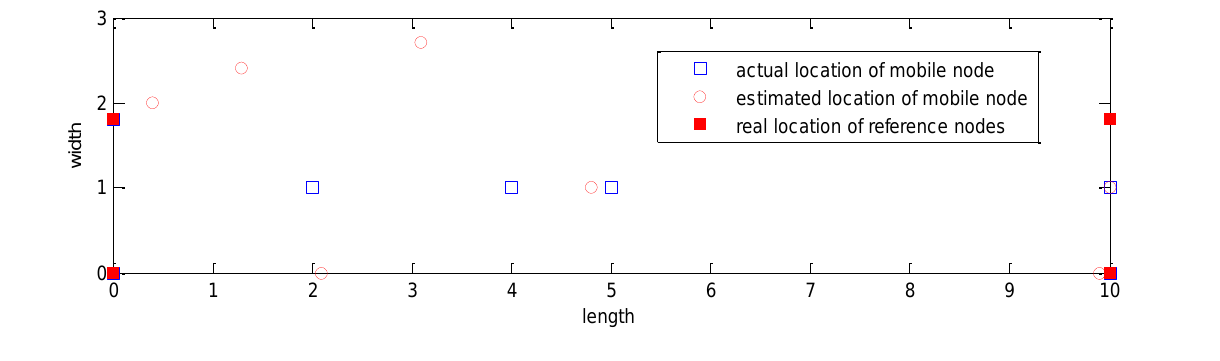
Table 5 . The experiment test results of positioning system (in